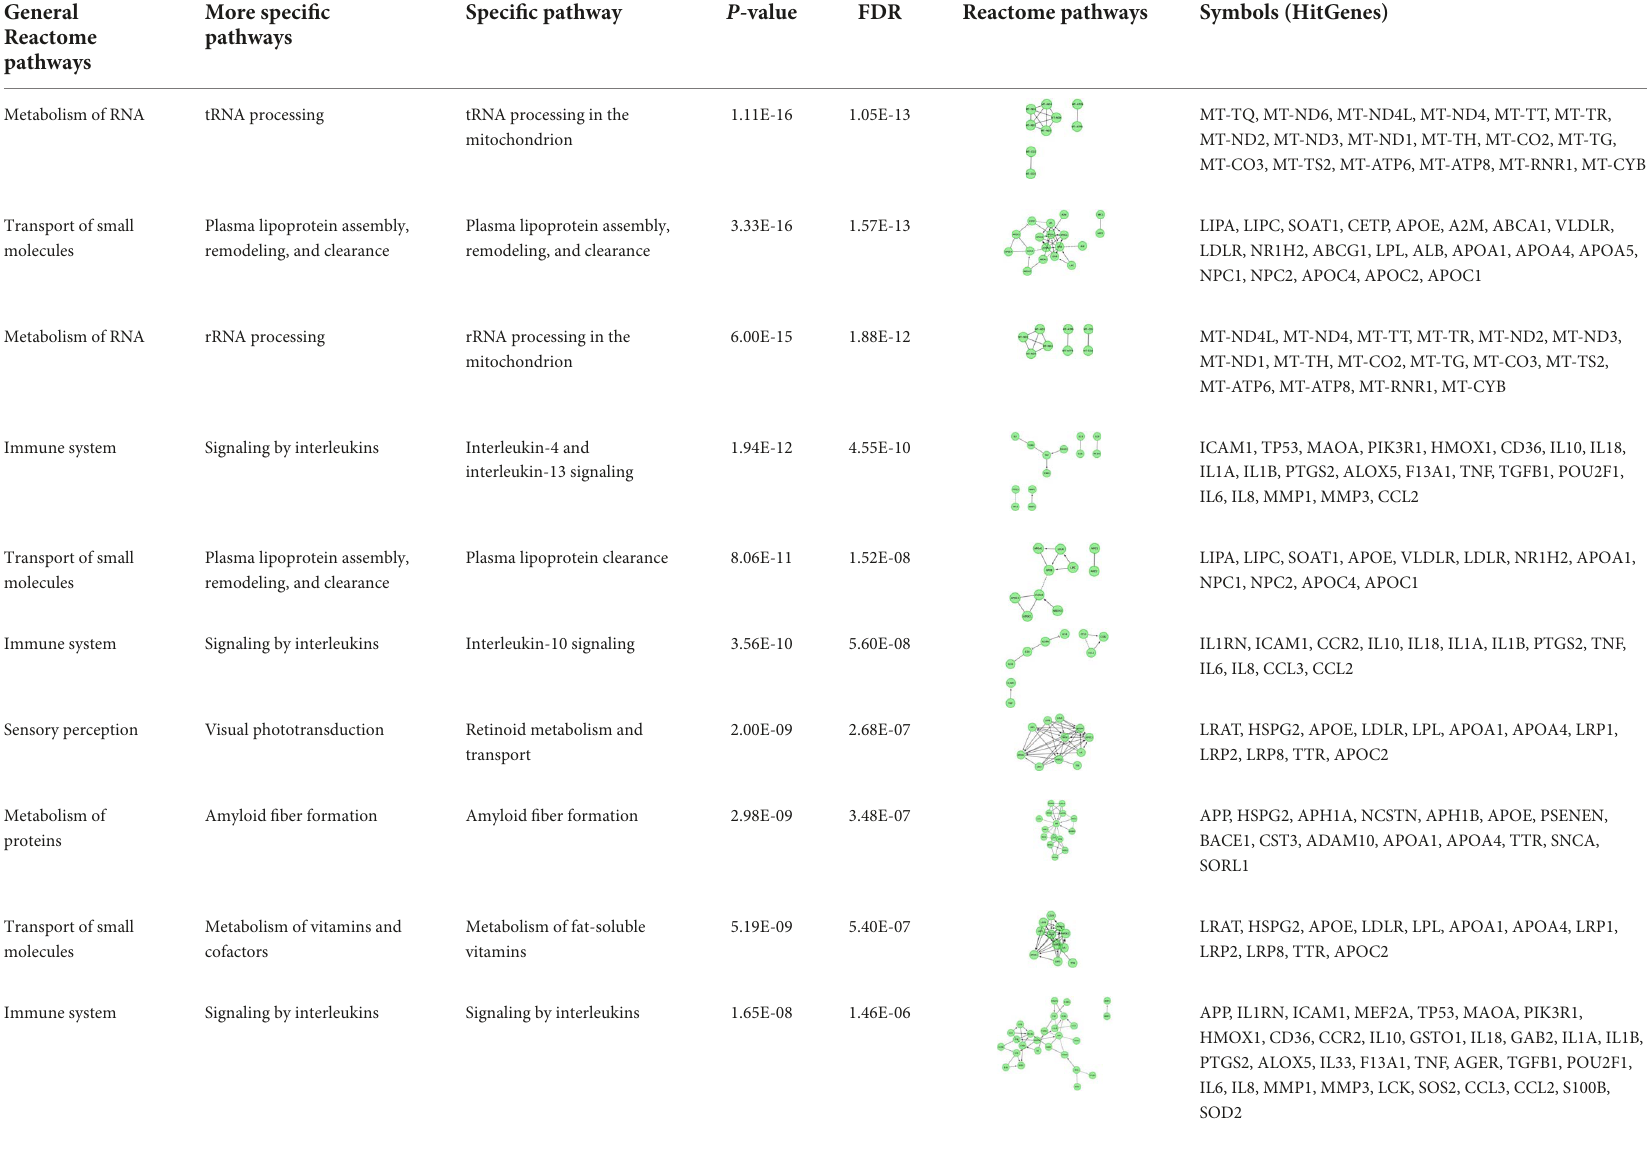
TABLE 1 Updated top 10 Reactome